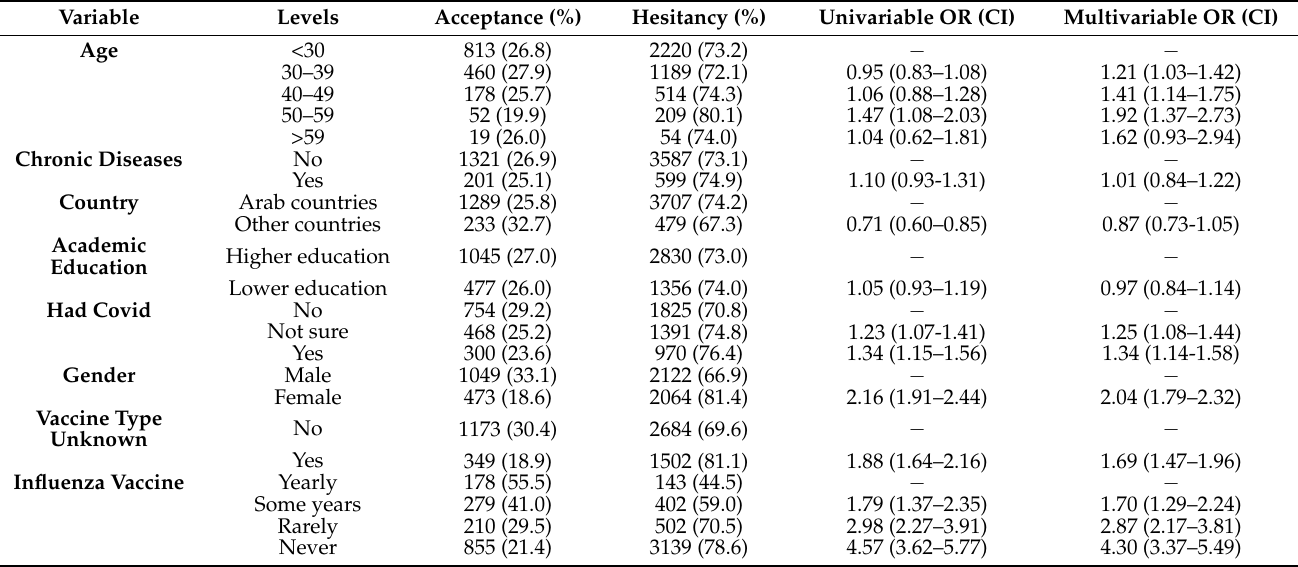
Table 3. Univariate and Multivariate Analyses of Factors Affecting